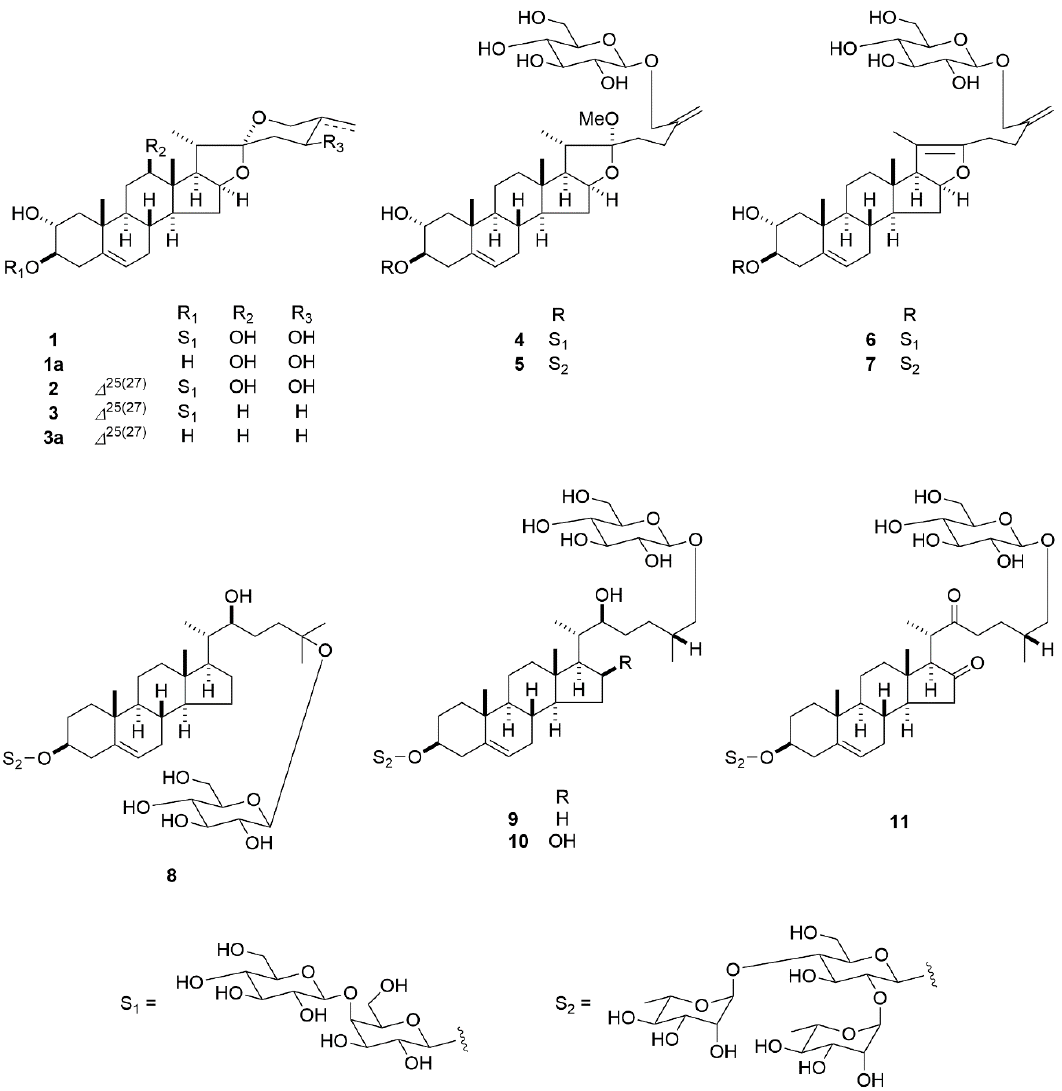
Figure 1. Structures of 1 , 1a , 2 , 3 , 3a , 4 – 11 .